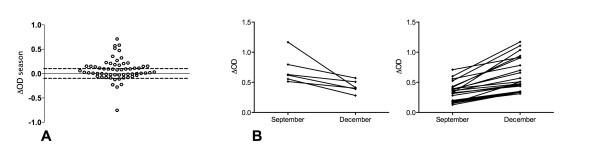
Individual evolution of the IgG response to gSG6-P1 from September to December. Individual ΔODseason of the IgG response specific to gSG6-P1 are presented (A). Individual evolutions of ΔOD from September to December are individually shown and positive (ΔODseason > 0.1) or negative (ΔODseason < -0.1) evolutions are separately presented (B).